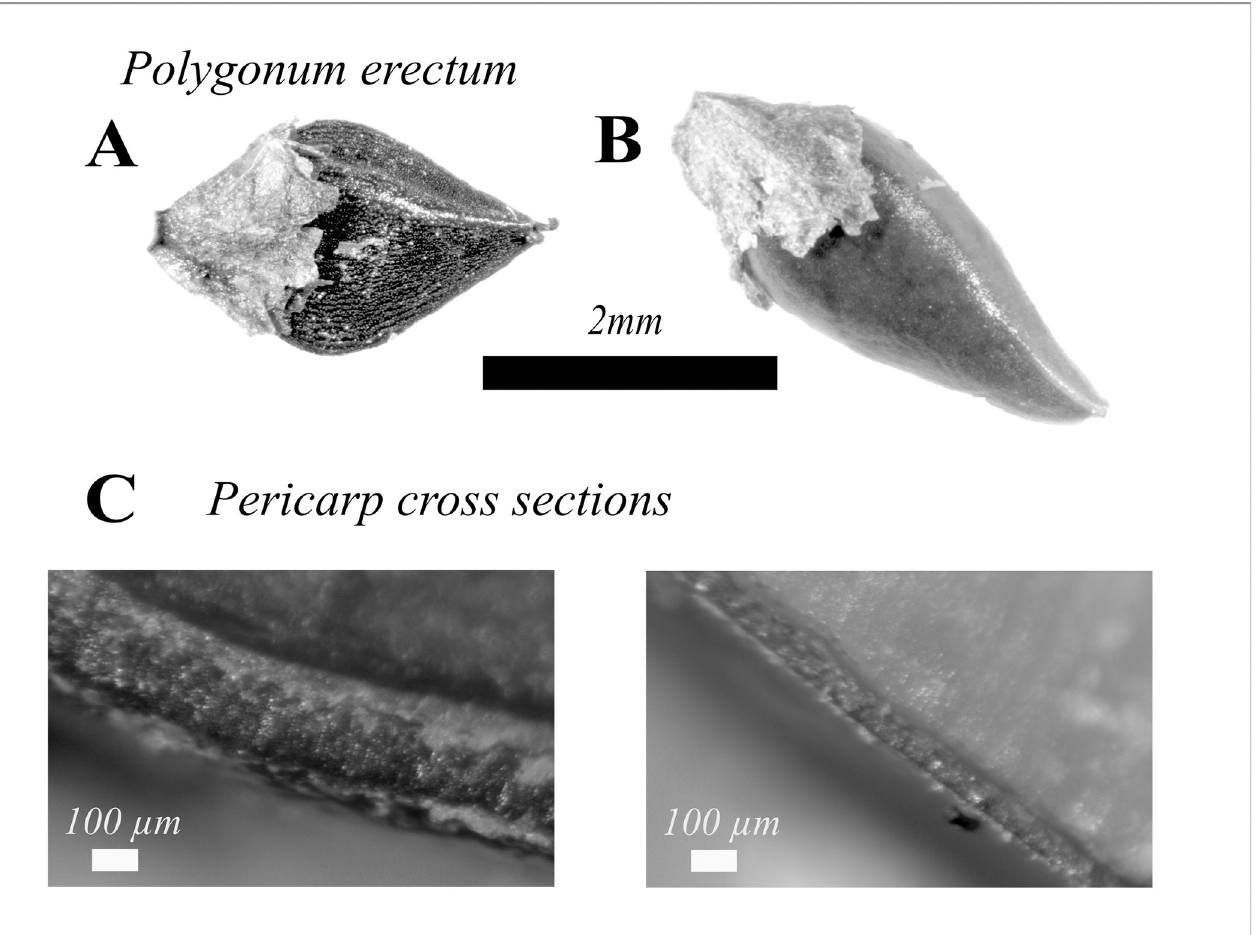
Fig 1. Fruit (achene) dimorphism in erect knotweed: A ) thick, tubercled pericarp morph fruit (achene) that is > 80% dormant after 6 weeks of cold, moist stratification; B ) thin, smooth pericarp morph fruit (achene), which is > 50% non-dormant after 6 weeks of cold, moist stratification, and; C ) pericarp cross- sections, showing relative thickness of the pericarp, which restricts germination by preventing moisture from reaching the seed.